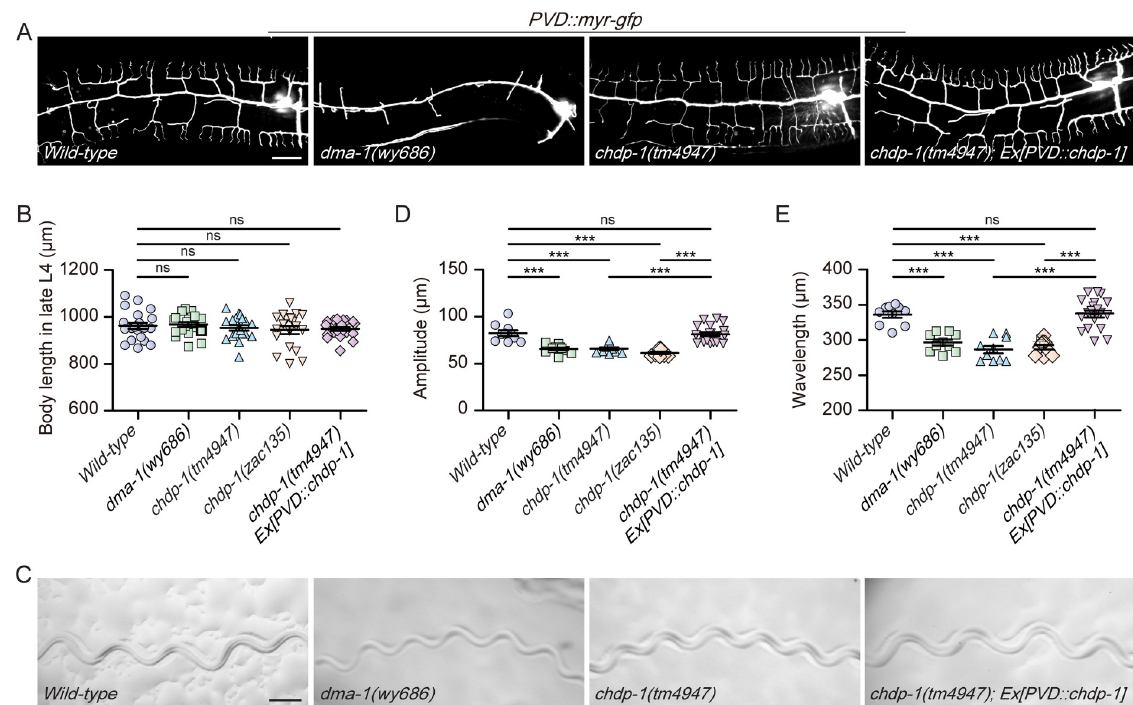
Fig 5. CHDP-1 is required for PVD’s proprioceptive function. (A) Confocal images of the PVD morphologies of wild-type , dma-1(wy686) , chdp-1(tm4947) and chdp-1(tm4947) mutant expressing CHDP-1 under the PVD specific promoter. Scale bar: 20 μ m. (B) Quantification of the body length in late L4 stage for the genotypes mentioned above. Error bars: SEM. ns: non-significant. n = 10–20 worms for each genotype. (C) Images showing the representative moving tracks of wild-type , dma-1(wy686) , chdp-1(tm4947) and chdp-1(tm4947) mutant expressing CHDP-1 under the PVD neuron-specific promoter. Scale bar: 200 μ m. (D-E) Quantification of the (D) amplitude and (E) wavelength of the moving tracks in late L4 stage for the genotypes mentioned above. Error bars: SEM. ��� p < 0.001 by one-way ANOVA with the Tukey correction. ns: non-significant. n = 10–20 worms for each